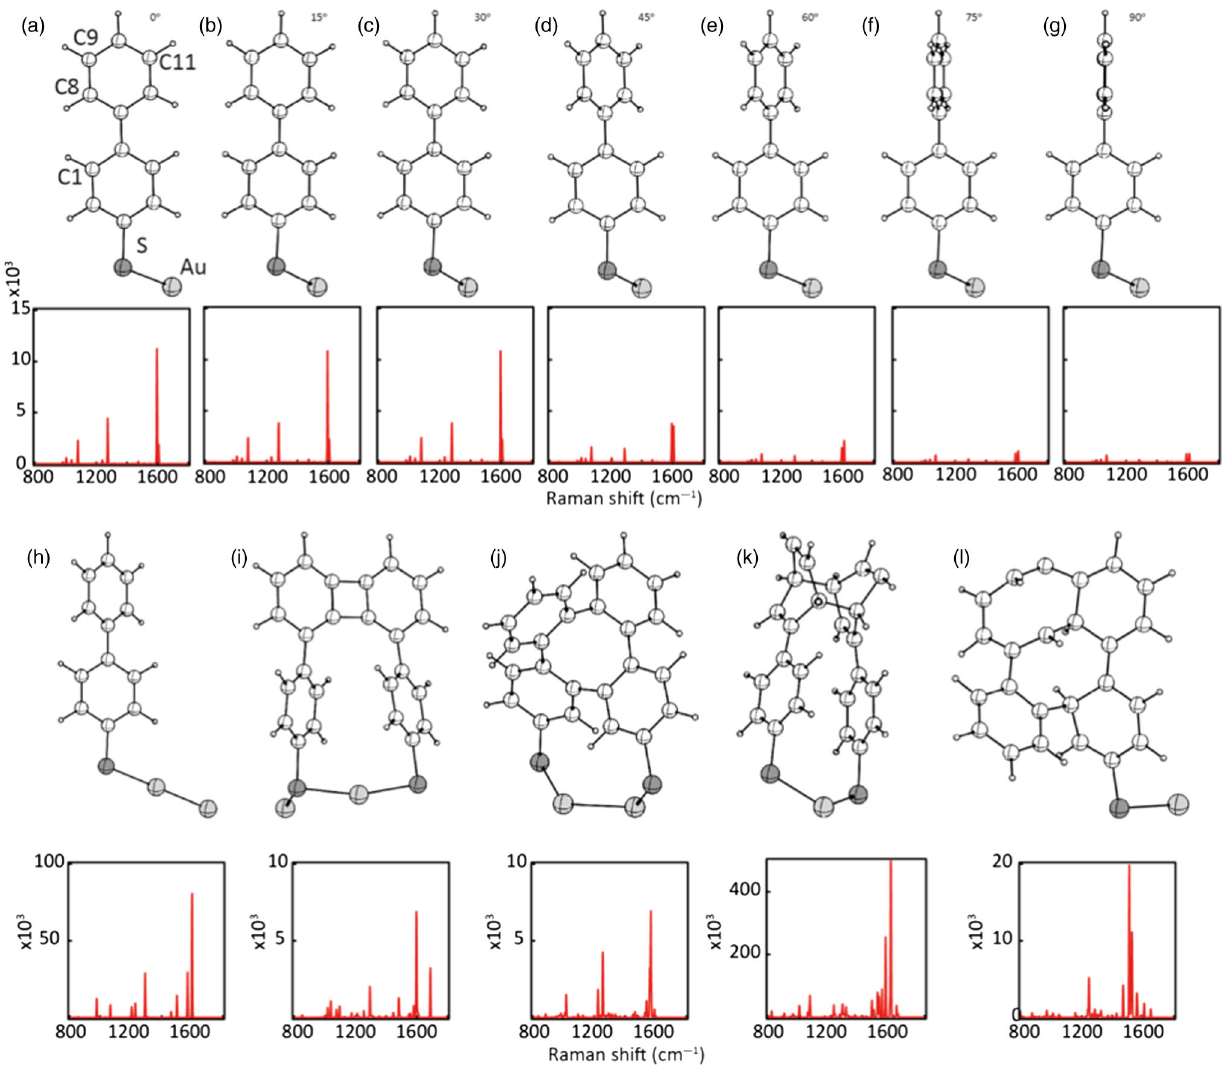
FIG. 13. Simulated 3D molecular structures for different BPT configurations and their corresponding Raman activity (below). (a) – (g) Molecular torsion (0 – 90°) around central carbon linker for a single molecule. (h) Effect of the addition of an extra gold atom. (i) – (l) Possible cross-linked structures between neighboring BPT molecules after irradiation: (i) C8-C9 dimerization, (j) C1-C8 dimerization, (k) C8-C11 dimerization, and (l) C1-C8-C9 with ring-opening